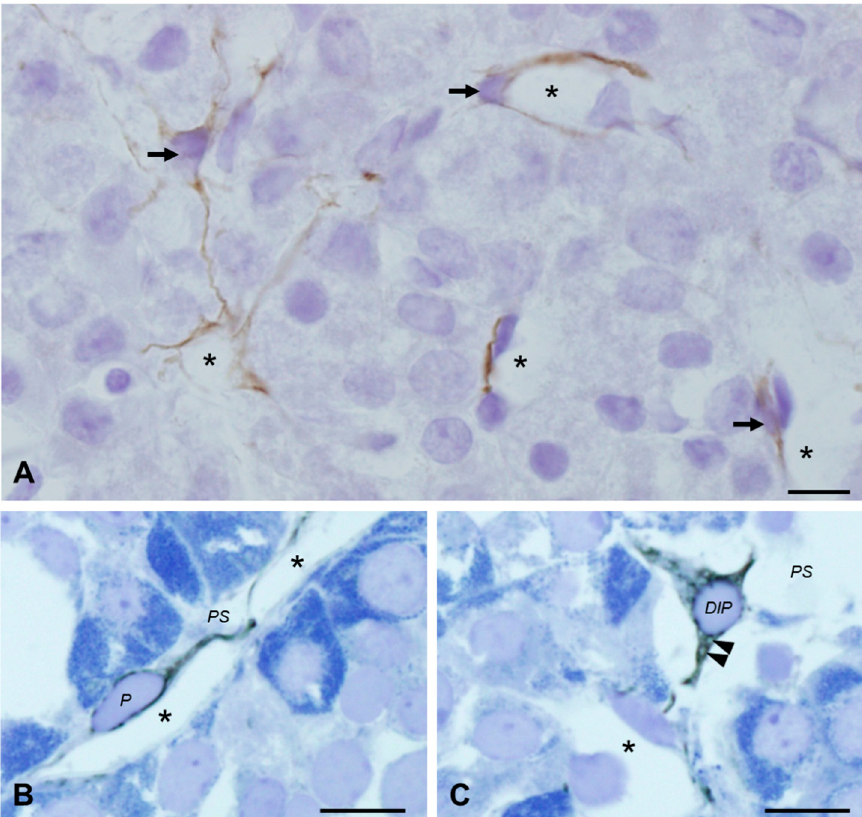
Figure 1. Light microscopy of desmin immunohistochemistry in the anterior pituitary glands of adult normal rats ( A – C ). Homogeneous brown immunopositive signals (arrows) appear on the typical 8-µm cryosections representing both pericytes and novel desmin-immunopositive perivascular cells ( A ), whereas semithin sections of immunocryo-epoxy resin embedding blocks with toluidine blue counterstaining reveal morphological differences between pericytes ( P in B ) and novel desmin- immunopositive perivascular cells ( DIP in C ). Unstained circular cavities in the black cytoplasm of novel desmin-immunopositive perivascular cells (arrowheads) are the dilated lumen of rERs: capil- laries (asterisks); perivascular space ( PS ). Bars 10 µm.